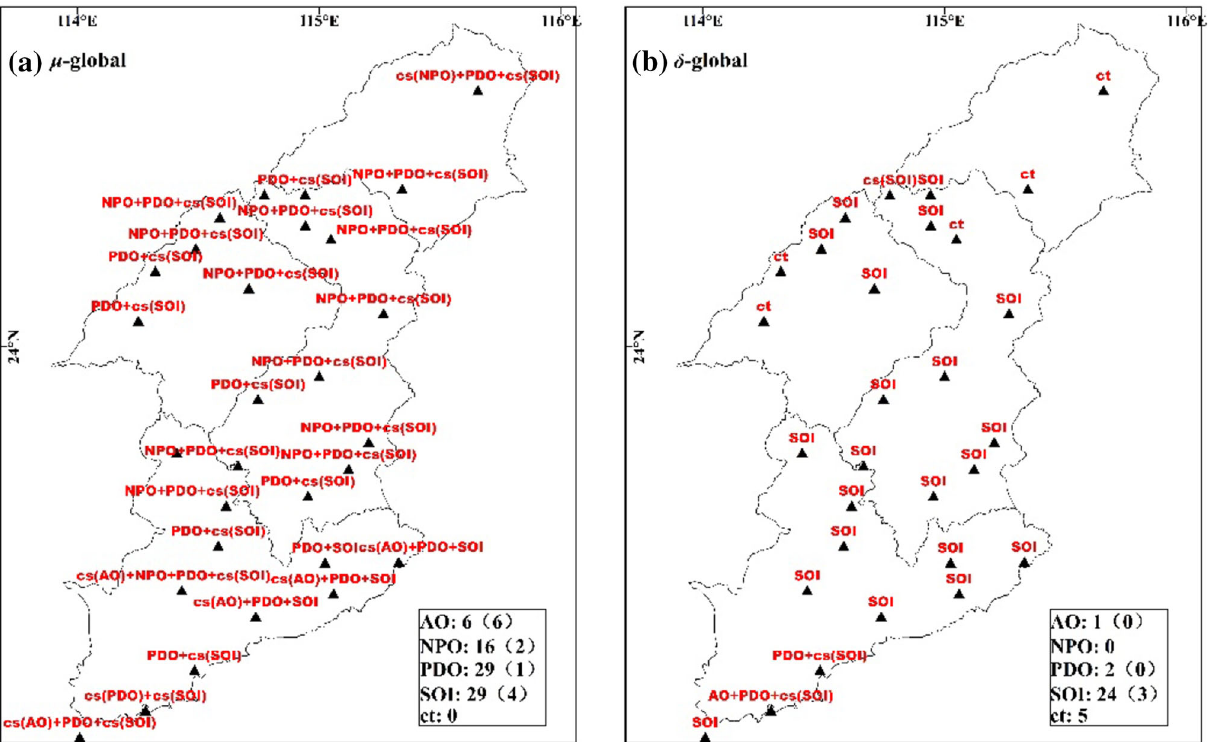
Fig. 5 The climatic indices that are closely related to the location ( l ) and scale ( d ) parameters in the global model. The numbers in the brackets denote the number of stations with nonlinear relations